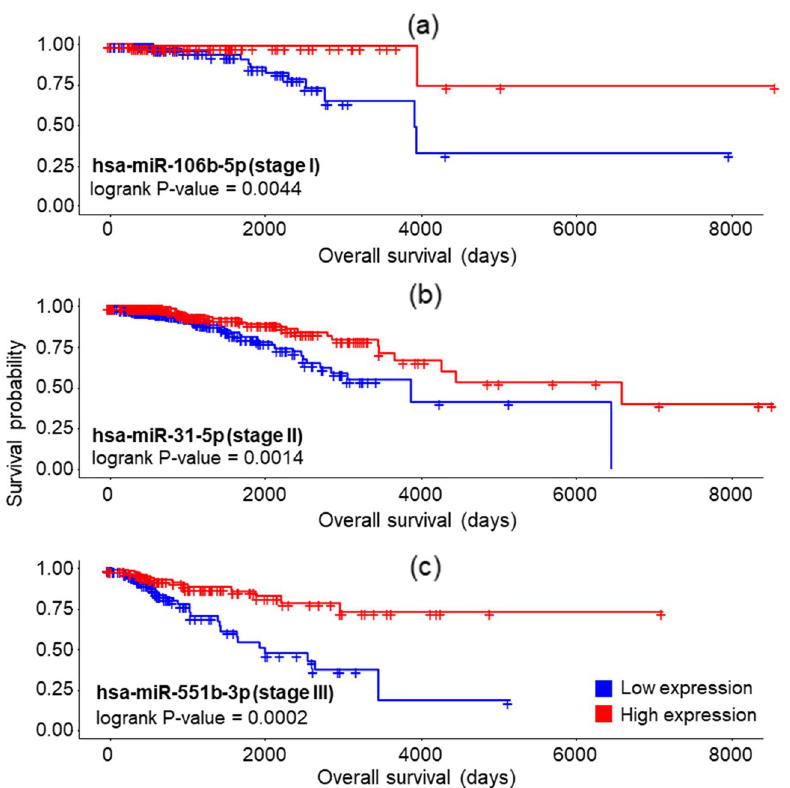
Figure 7. Kaplan–Meier survival plots for the top significant miRNAs in stage-specific breast cancer networks 21 . The high-expressed hsa-miR-106b-5p ( a ), hsa-miR-31-5p ( b ), and hsa-miR-551b-3p ( c ) were prognostic in stage I, II, and III, respectively. None of the microRNAs in the stage IV ceRNA network was significant from survival